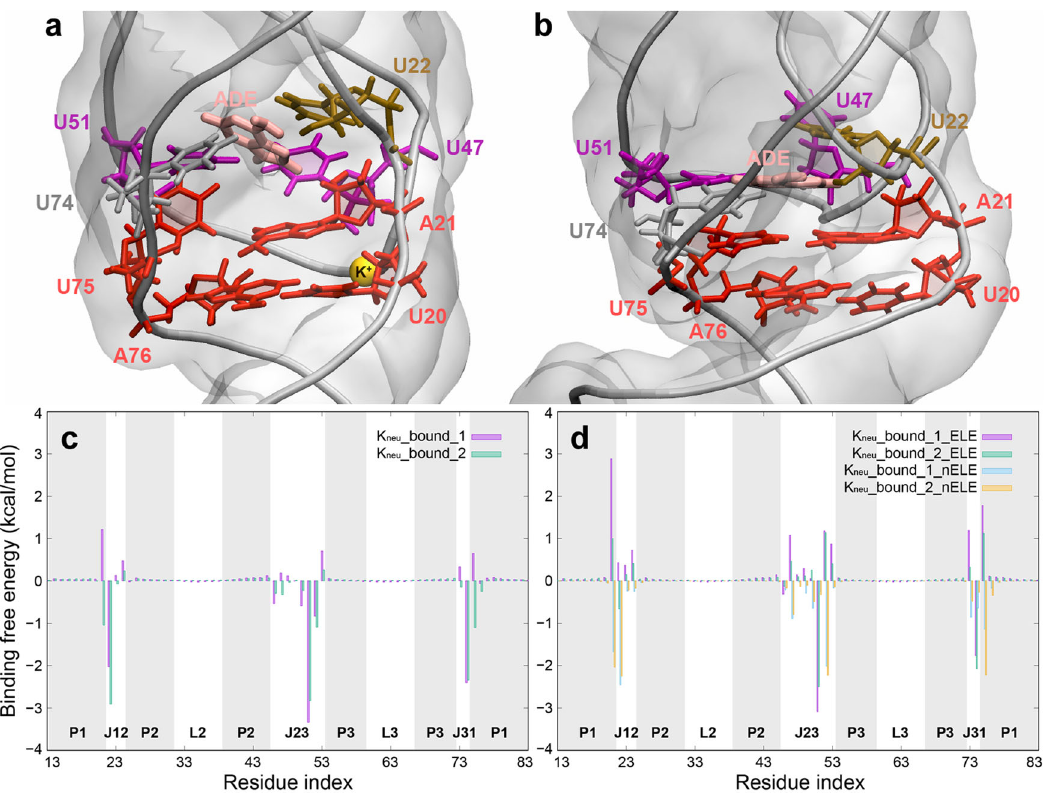
Fig. 6 The binding pocket structure and ligand binding af fi nities in Mg 2 + -free environment. a The snapshots of typical structures near ligand binding pocket in K neu _bound_1. Because C J12-P1 is almost always in a loose state in K neu _bound_1, we have marked the important K + ion binding site (between P1 and J23, represented by orange sphere) in this state. b The snapshots of typical structures around ligand binding pocket in K neu _bound_2. c The contribution of each residue to the free energy (ligand binding to the AARA) in K neu _bound_1 and K neu _bound_2. d The contribution of each residue to the free energy is decomposed into electrostatic and non-electrostatic terms in K neu _bound_1 and K neu